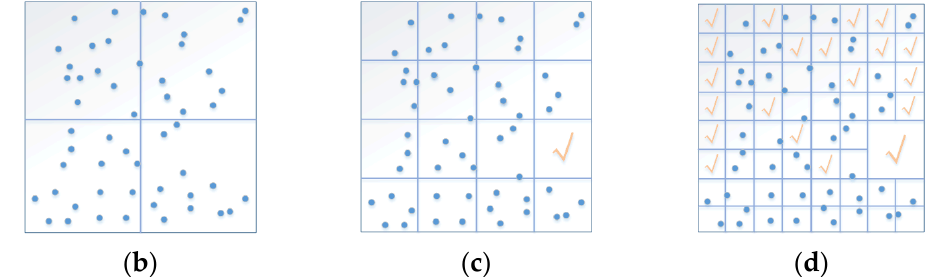
Figure 2. Detection of feature-sparse regions: ( a ) initialize detector, ( b ) first partitioning, ( c ) K-th partitioning, and ( d ) stop partitioning.